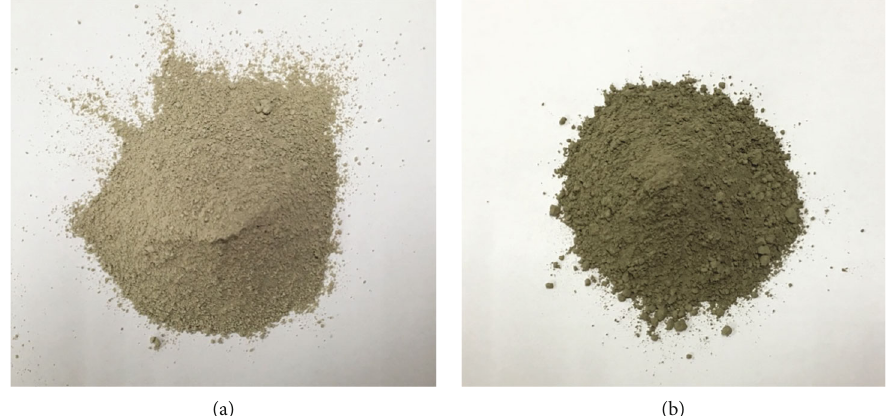
Figure 4: The (a) waste-soil and (b) binder used in this test.